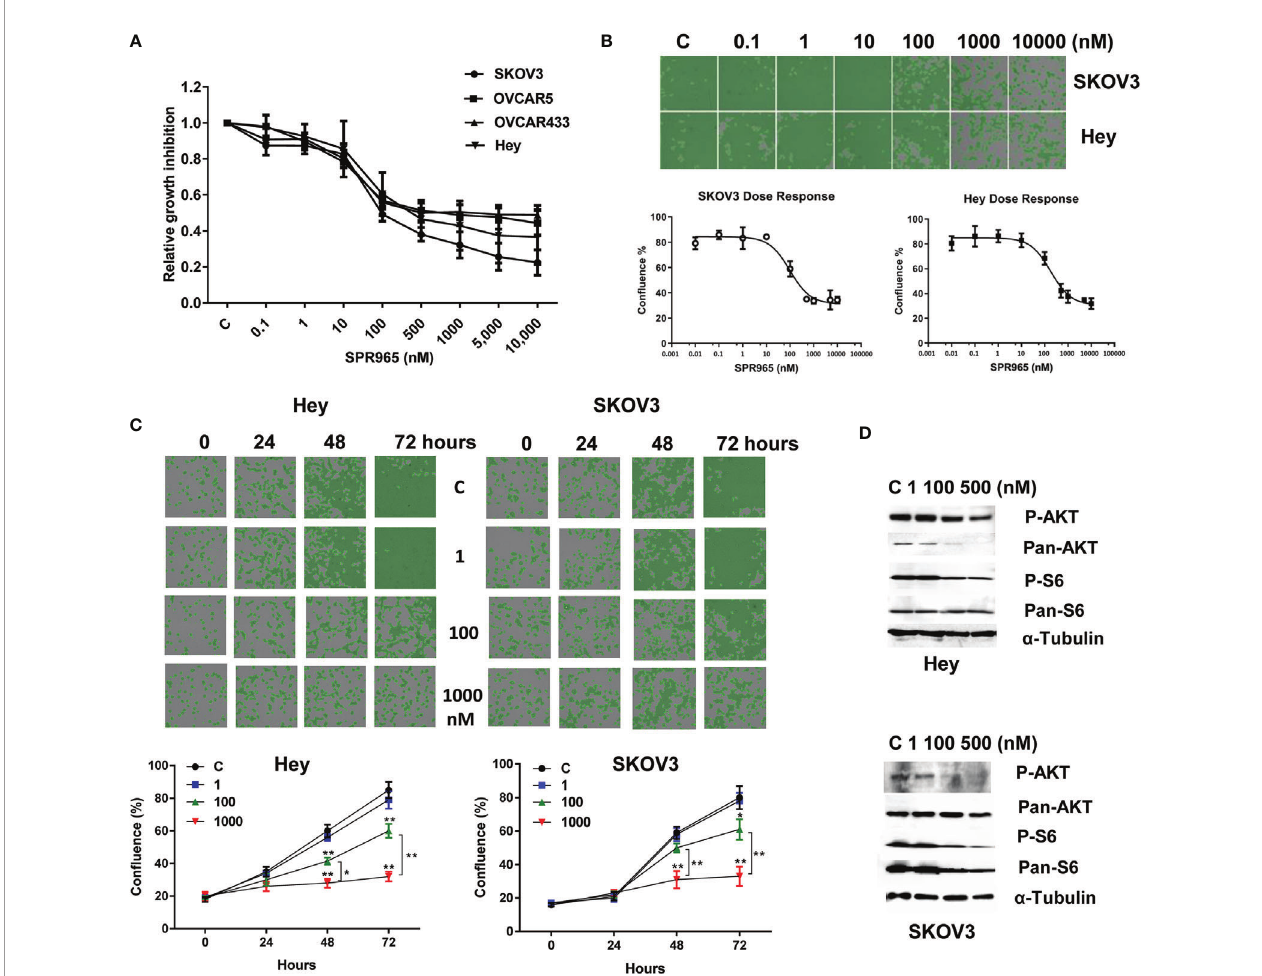
FIGURE 1 | SPR965 induced dose-dependent growth inhibition in ovarian cancer cells. The OVCAR5, OVCAR433, Hey, and SKOV3 cell were treated with various doses of SPR965 for 72 h. Cell proliferation was determined by MTT assay (A) Celigo Image Cytometer was used to determine the effect of SPR965 on cell proliferation in SKOV3 and Hey cells (B) . Relative survival was determined by dividing the number of remaining DHA treated cells by the number of remaining viable DMSO. Treatment of the cells with SPR965 at 1, 100, and 1,000 nM for 24, 48, and 72 h showed that SPR965 induced inhibition of cell proliferation in time dependent manner in both cell lines (C) . The images are one representative result of three independent experiments. Western blotting results showed that SPR965 reduced the expression of phosphorylated-AKT and phosphorylated-S6 in the Hey and SKOV3 cells (D) . *p < 0.05; **p <